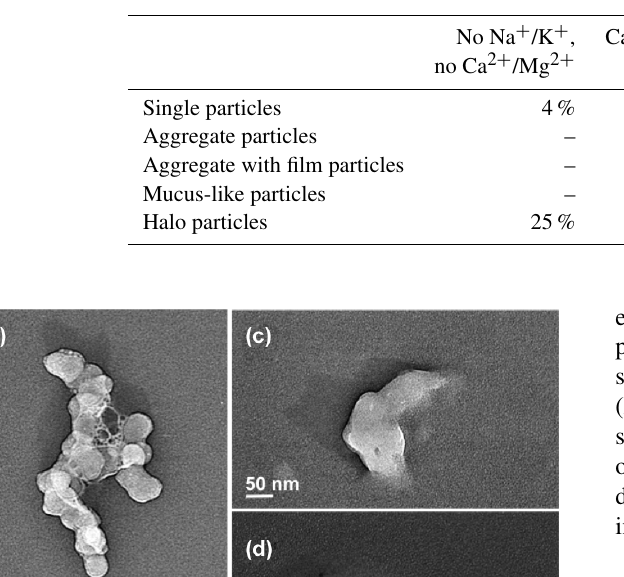
Table 2. Fraction of particles containing the ions Na + /K + or Ca 2 + /Mg 2 + , both Na + /K + and Ca 2 + /Mg 2 + , or neither Na + /K + nor Ca 2 + /Mg 2 + in single particles, “aggregate” particles, “aggregate with film” particles, “mucus-like” particles, and halo particles. The ions written in brackets in the last column indicate the prevalent type of ion in the respective type of particle.